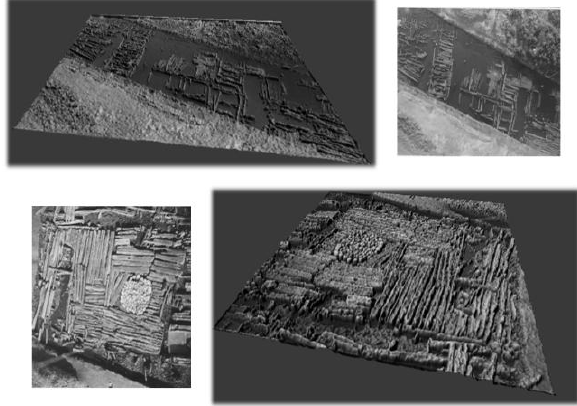
Figure 9: 3D visualization of a fragment of the fortified settlement developed using Blender